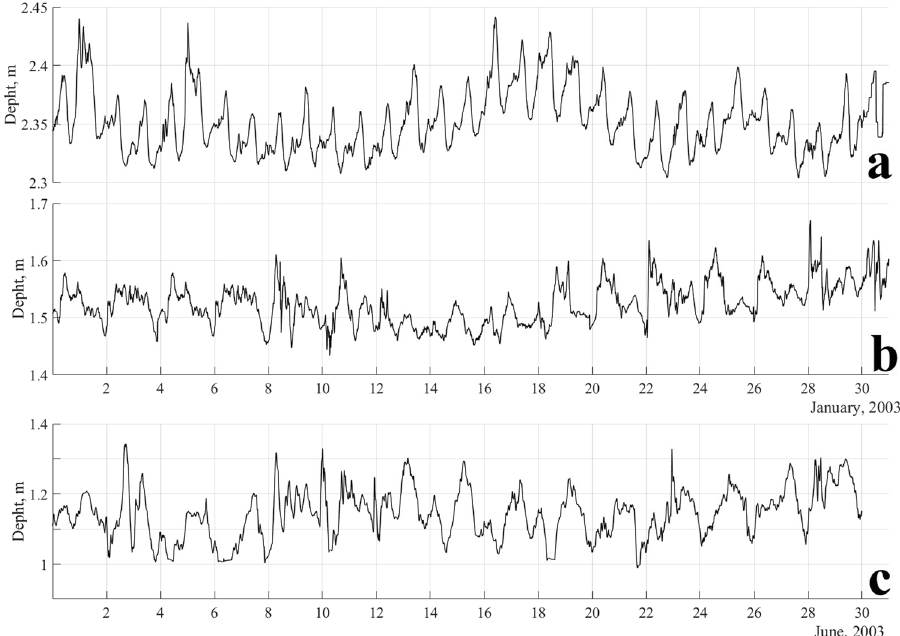
Figure 2. Oscillations of the water level in the lake at sites in the ( a ) northeast, ( b ) east and ( c ) west for the two sampling